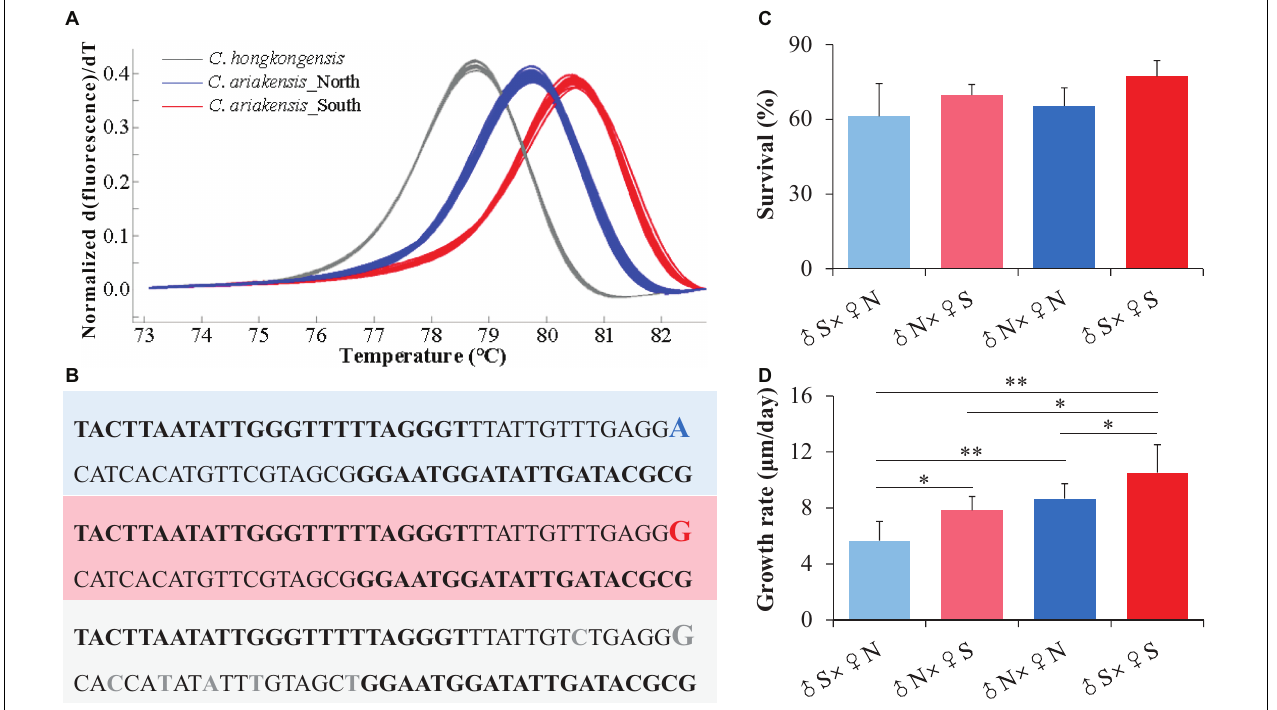
FIGURE 2 | Taxonomic analyses of the northern and southern estuarine Crassostrea ariakensis oysters. (A) Normalized melting curves of the amplicons from the COI gene segment for the northern (blue) and southern (red) C. ariakensis , and Crassostrea hongkongensis (gray) oysters. (B) Sequence variations of the COI gene segment among the northern (blue) and southern (red) C. ariakensis , and C. hongkongensis (gray) oysters. (C) Survival and (D) growth rates during larvae development from the D-shaped to eye-spot stages of the four full-sib families. N : S : sperm of the southern oysters (TS), S : eggs of the southern oysters (TS), sperm of the northern oysters (BZ), ♂ ♀ ♂ N : eggs of the northern oysters (BZ). Asterisks indicate significant differences (* p < 0.05 and ** p < 0.01), and error bars represent sd ♀